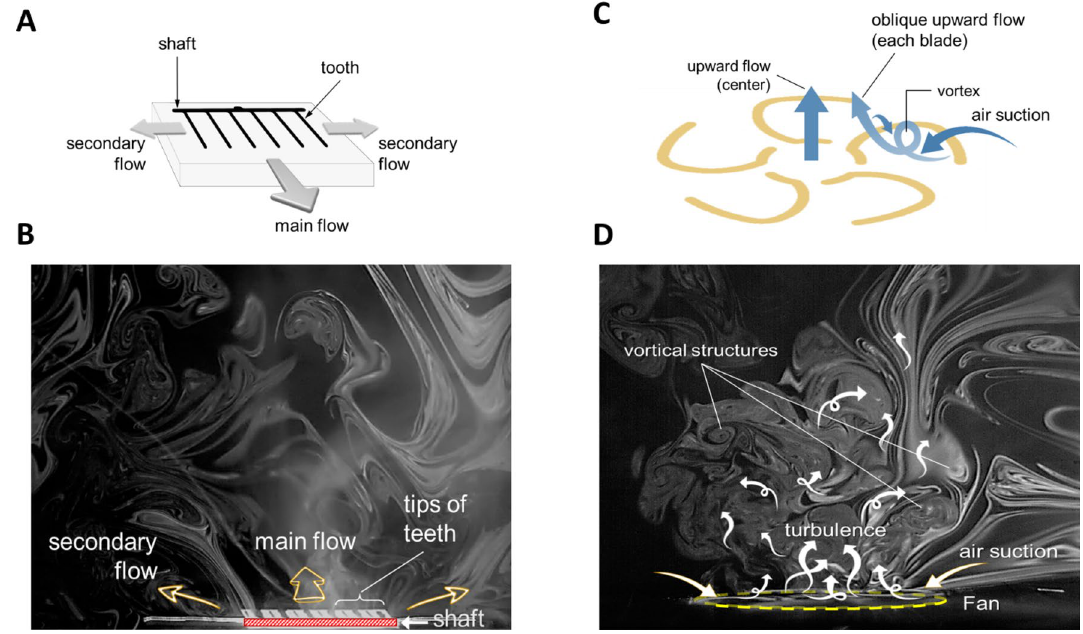
Figure 2. Smoke flow visualizations showing plasma reactor flow distribution with two reactor designs: Comb and Fan. ( A ) Comb reactor flow actuation showing the direction of three wall jets with the main wall jet flow from the shaft towards the teeth tips, ( B ) smoke flow visualization of Comb reactor actuated flow, ( C ) Fan reactor flow actuation by the fan blades which interacts to result in overall conical flow thrusted upwards from the reactor base, ( D ) smoke flow visualization of Fan reactor actuated flow. Figure adapted from previous publication 15 .